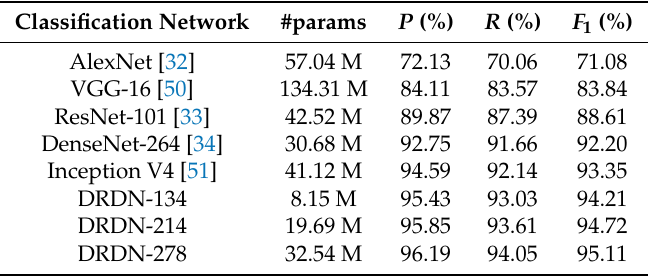
Table 5. Performance comparison of different classification